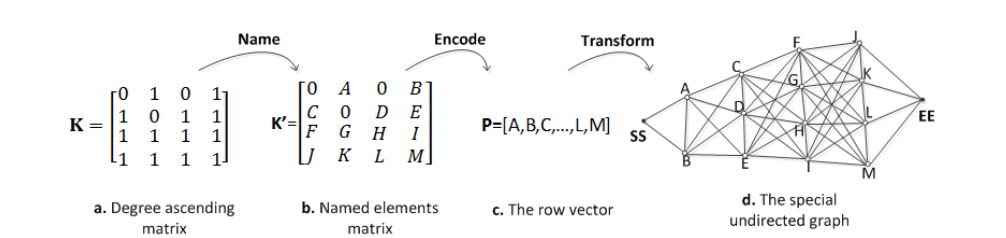
Figure 2. Transform